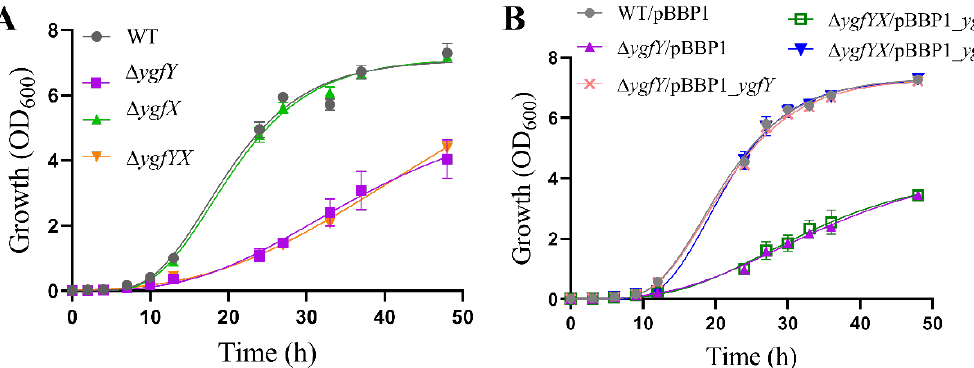
Figure 1. YgfY but not YgfX affected growth of S. oneidensis MR-1. ( A ) Growth of WT and mutants. ( B ) Complementation of YgfY by expressing it from a constitutive promoter in pBBP1. All strains were cultured in LB at 16 °C under aerobic condition. The data are the mean ± SD ( n = 3). Error bars for some data points were too small to be shown.